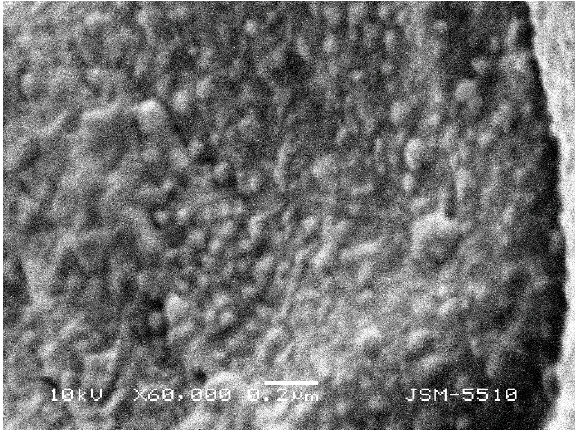
Figure 5. A SEM image of a cotton fabric treated with Zn 4 (D16)(NO 3 ) 8 .